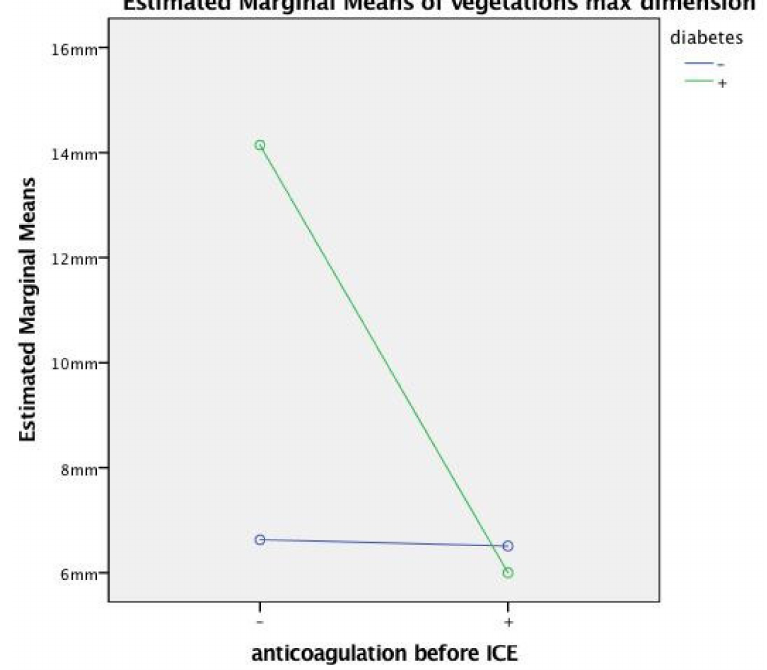
Figure 4. Plot illustrating diabetes and anticoagulation before ICE interaction by a two-way between-groups ANOVA. - = finding absent; + = finding present; ICE = intracardiac